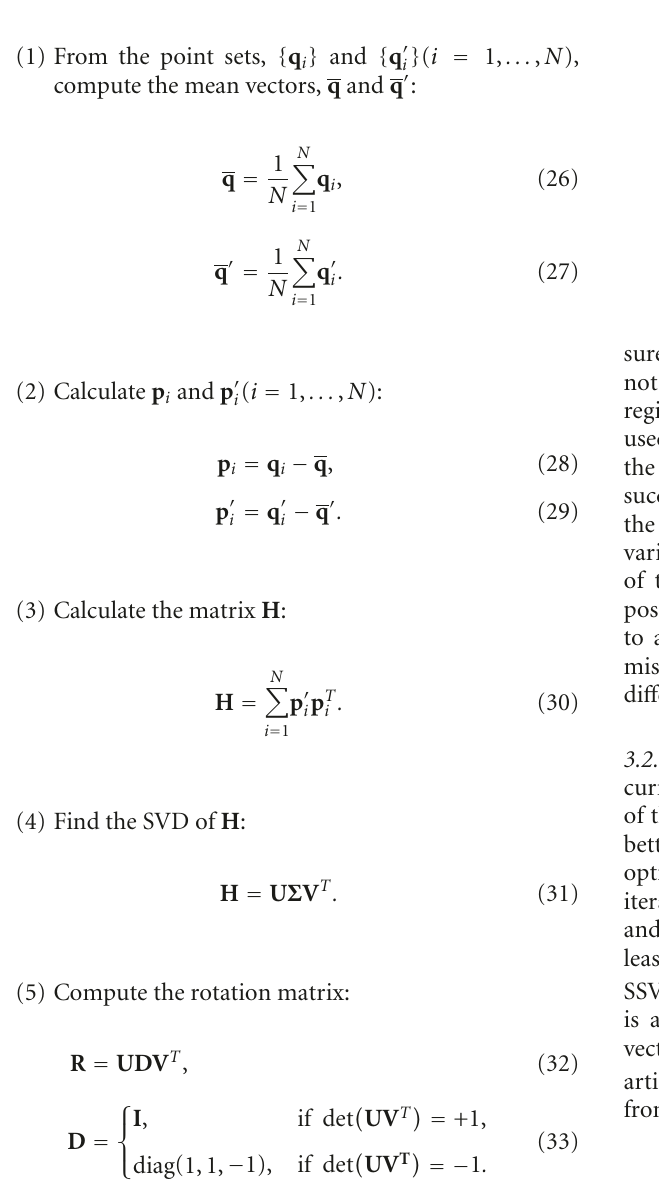
Figure 3: An example of the model